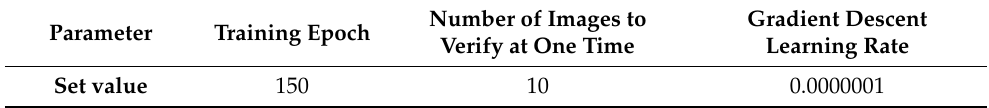
Table 6. The parameter